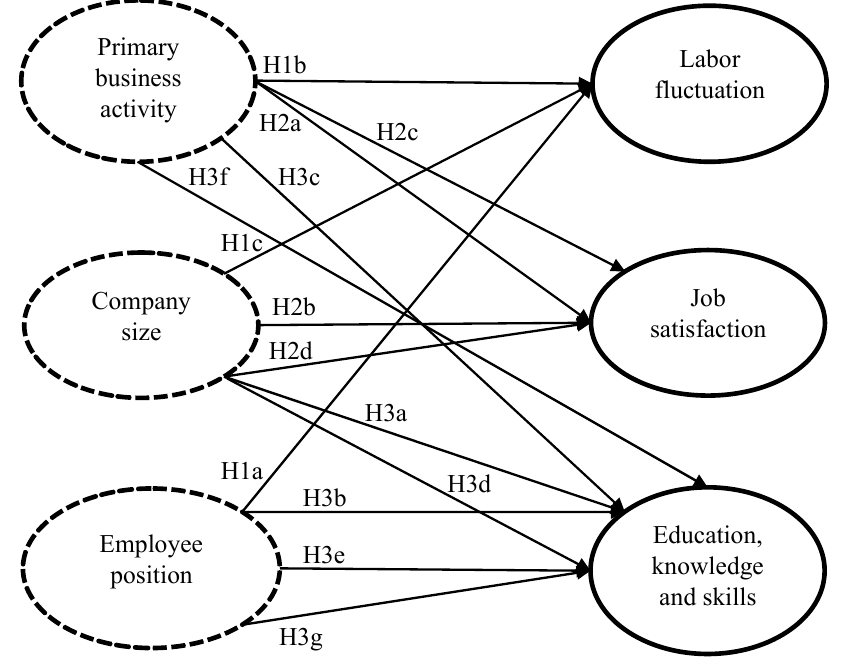
Figure 1. Model of job satisfaction, labor fluctuation, education, knowledge and skills.